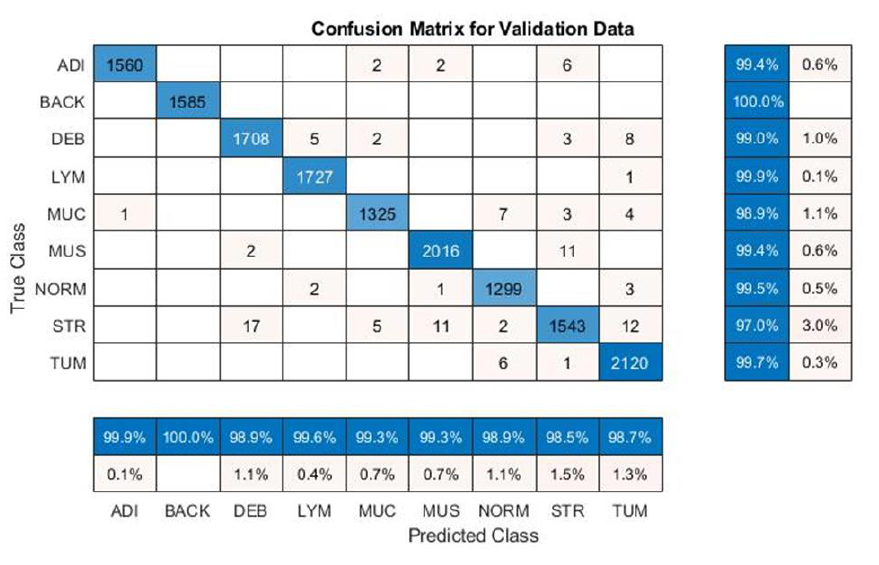
Figure 7. Experiment I: the accuracy of nine classes (CRC-VAL-HE-100K).